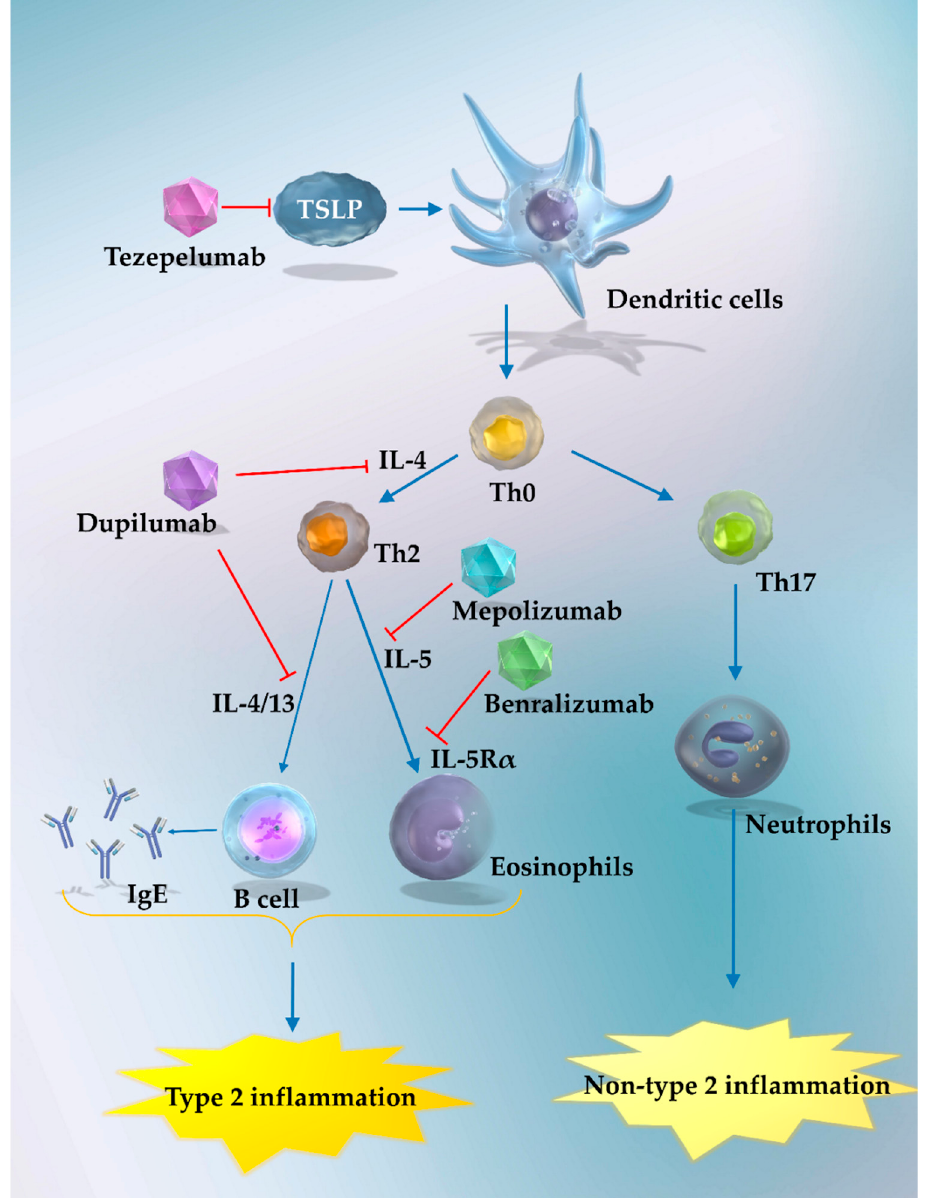
Figure 7. Overview of the t hymic stromal lymphopoietin (TSLP)-triggered immune response and pathogenesis of asthma. The cytokine TSLP is secreted by mucosal epithelial cells and its receptors are highly expressed on dendritic cells. TSLP induces a Th2-type immune response involving IL-4, IL-5, and IL-13 and is responsible for the pathogenesis of type 2 asthma. TSLPs are also involved in the pathogenesis of non-type 2 asthma by inducing the differentiation of Th17 cells by the activation of dendritic cells. Dupilumab targets IL-4 and IL-13, benralizumab targets IL-5R α , and mepolizumab targets IL-5, and these drugs are mainly clinically effective in type 2 asthma. Tezepelumab targets TSLP and is expected to have clinical efficacy in both type 2 and non-type 2 asthma; IL, interleukin; IgE, Immunoglobulin E; IL-5R α , interleukin-5 receptor